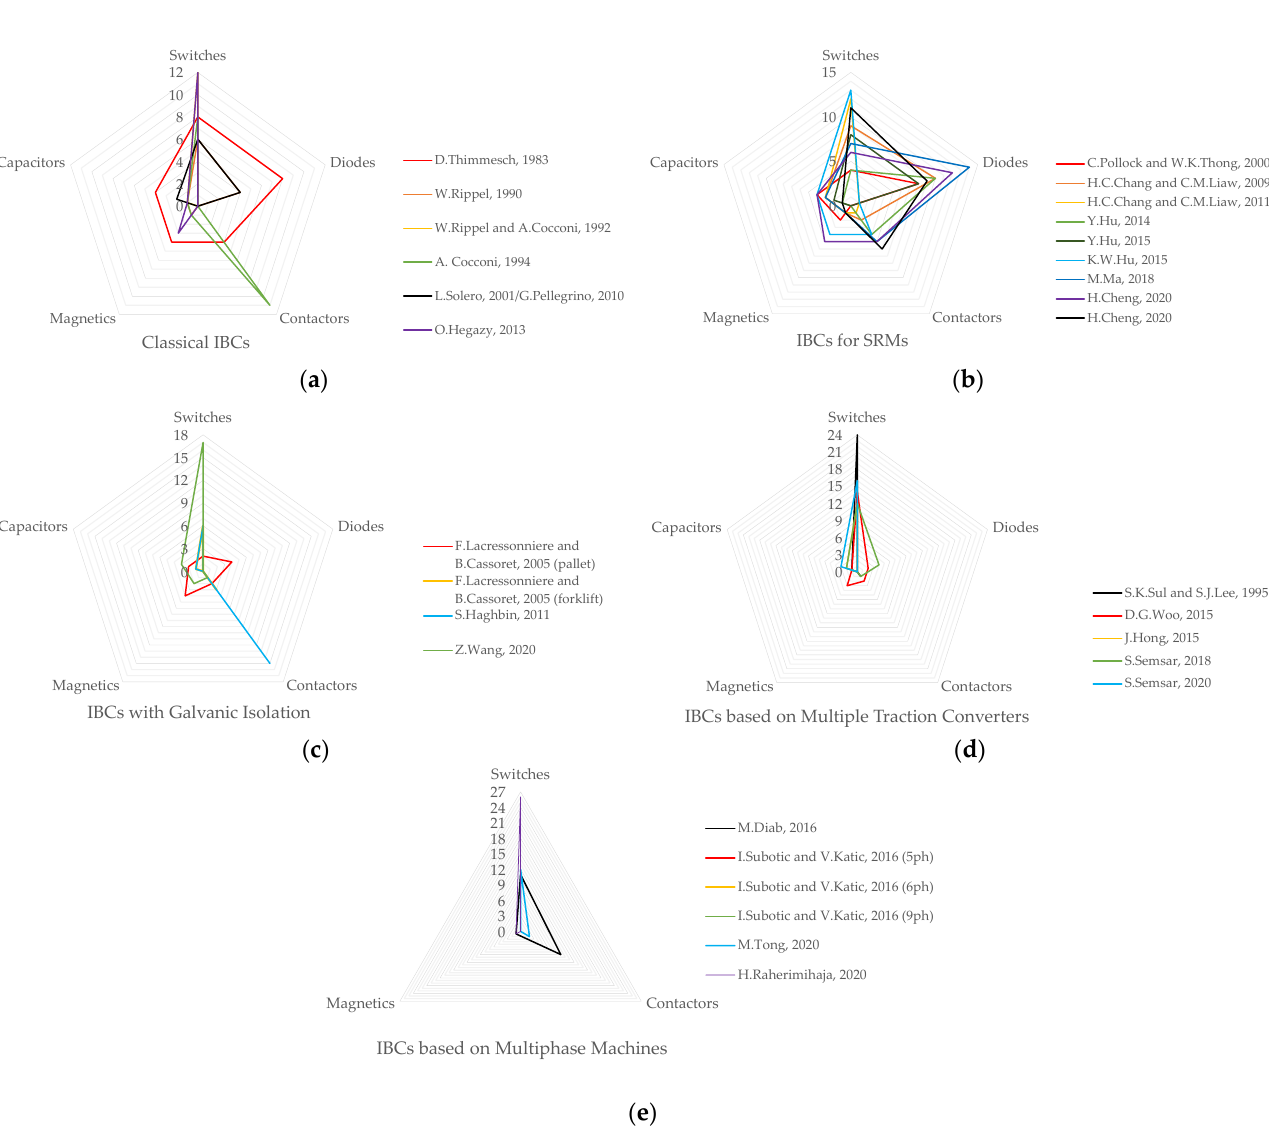
Figure 22. Radar charts illustrating the quantitative comparison between the presented: ( a ) classical IBCs; ( b ) IBCs for SRMs; ( c ) IBCs with galvanic isolation; ( d ) IBCs based on multiple traction converters; ( e ) IBCs based on multiphase machines.